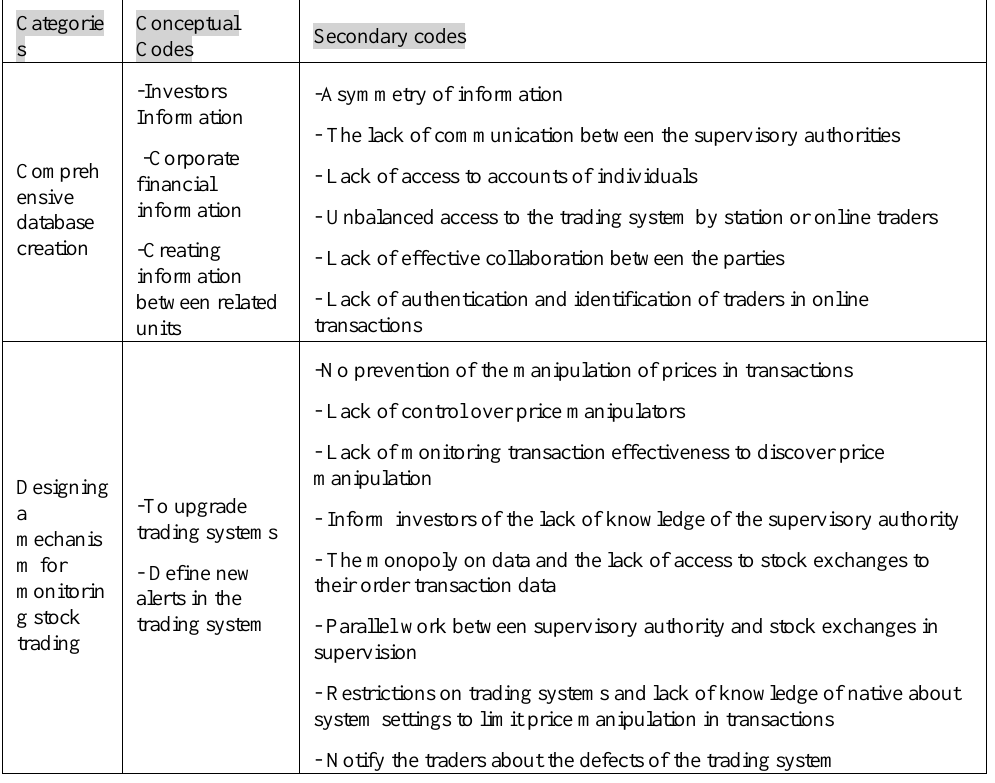
Table 3. Secondary and conceptual coding and